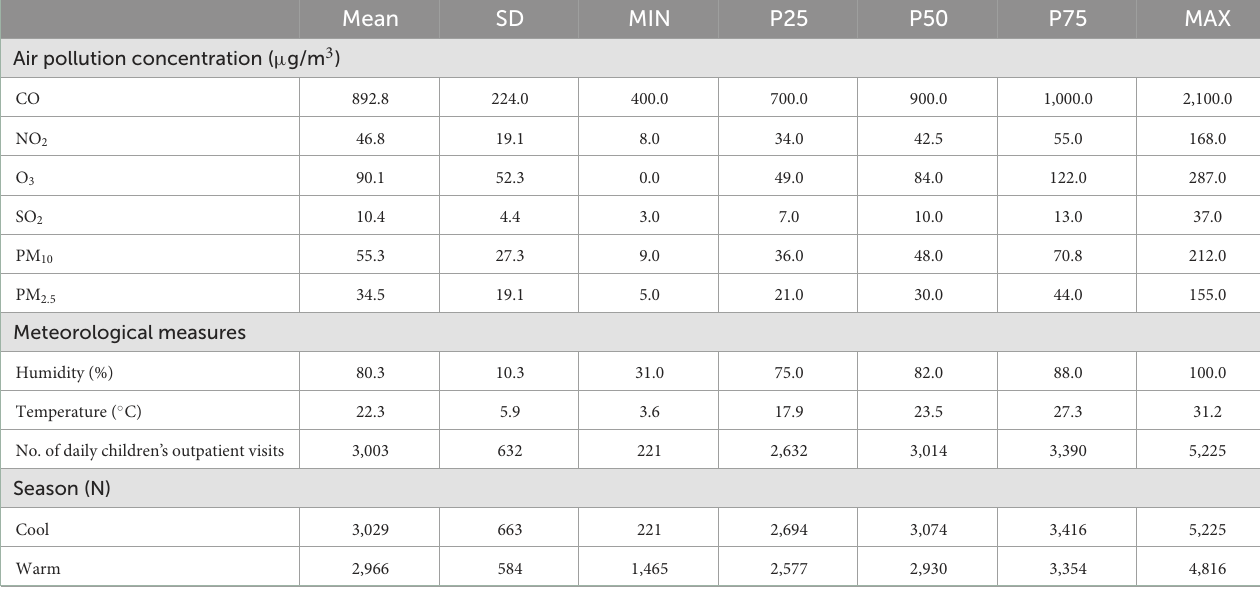
TABLE 1 Daily air pollutants, meteorological data, and children’s outpatient visits during the study.